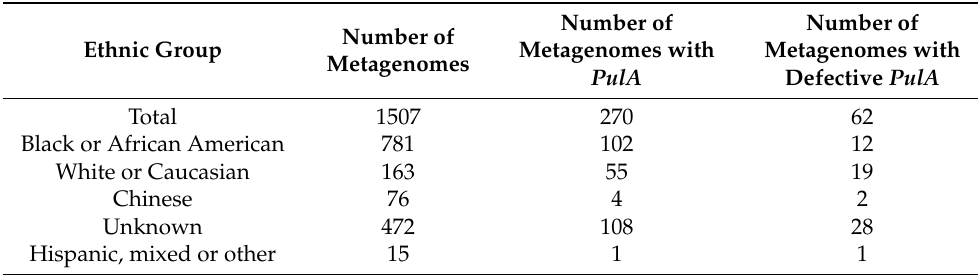
Table A1. Number of metagenomes (total 1507), with a pulA gene (intact and defective) and a defective pulA gene per ethnic group of